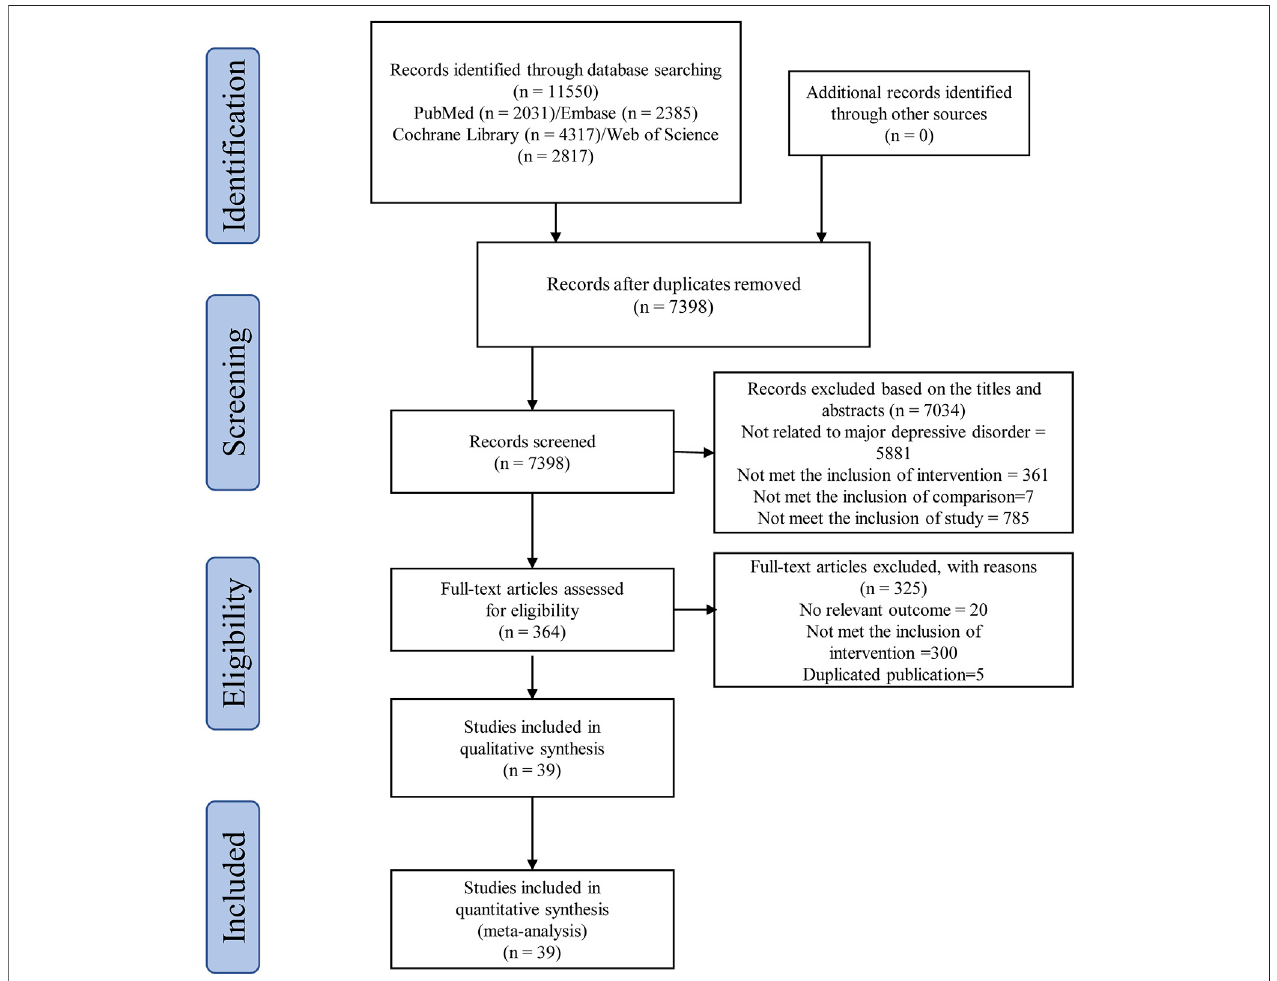
FIGURE 1 | Literature search and